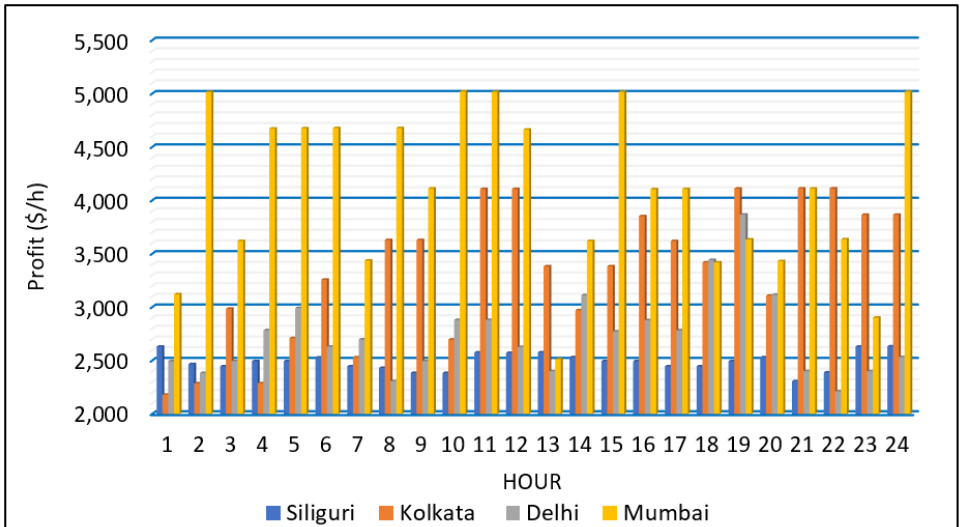
Figure 8. Average profit ($/h) comparison for 24 h.